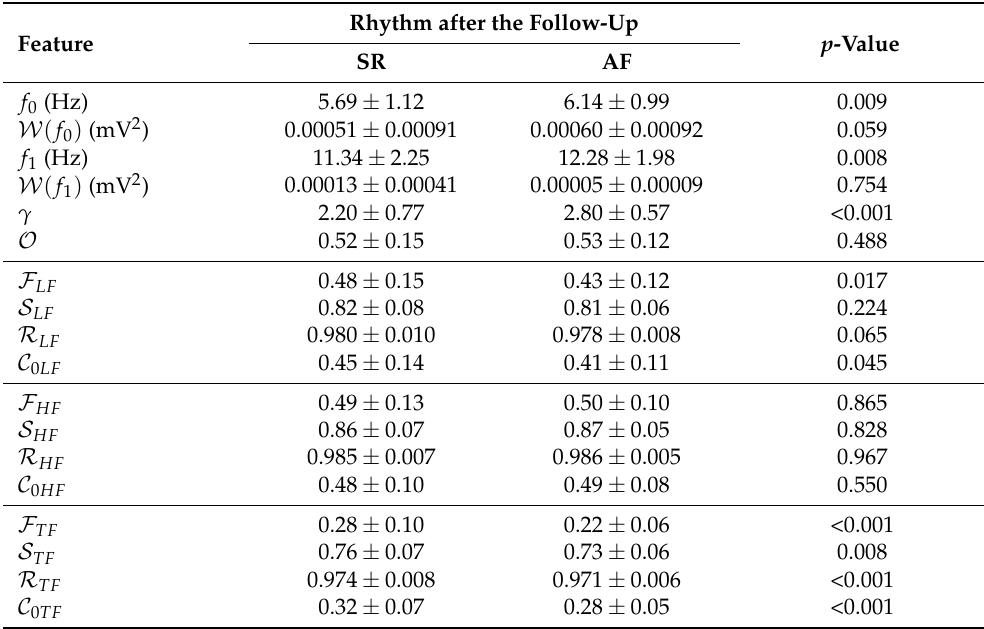
Table 1 improved classification performance of the prediction models. Table 2. Mean and standard deviation values for the analyzed metrics from the two groups of patients and their corresponding statistical significance ( p -value).